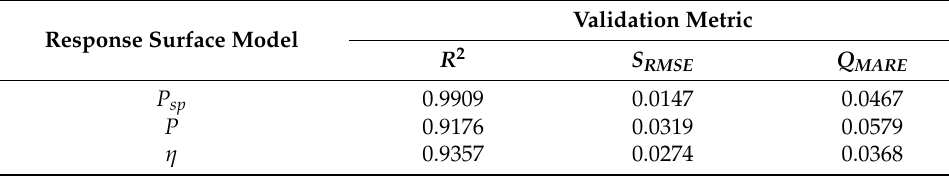
Table 4. Evaluation results of the RSM model.